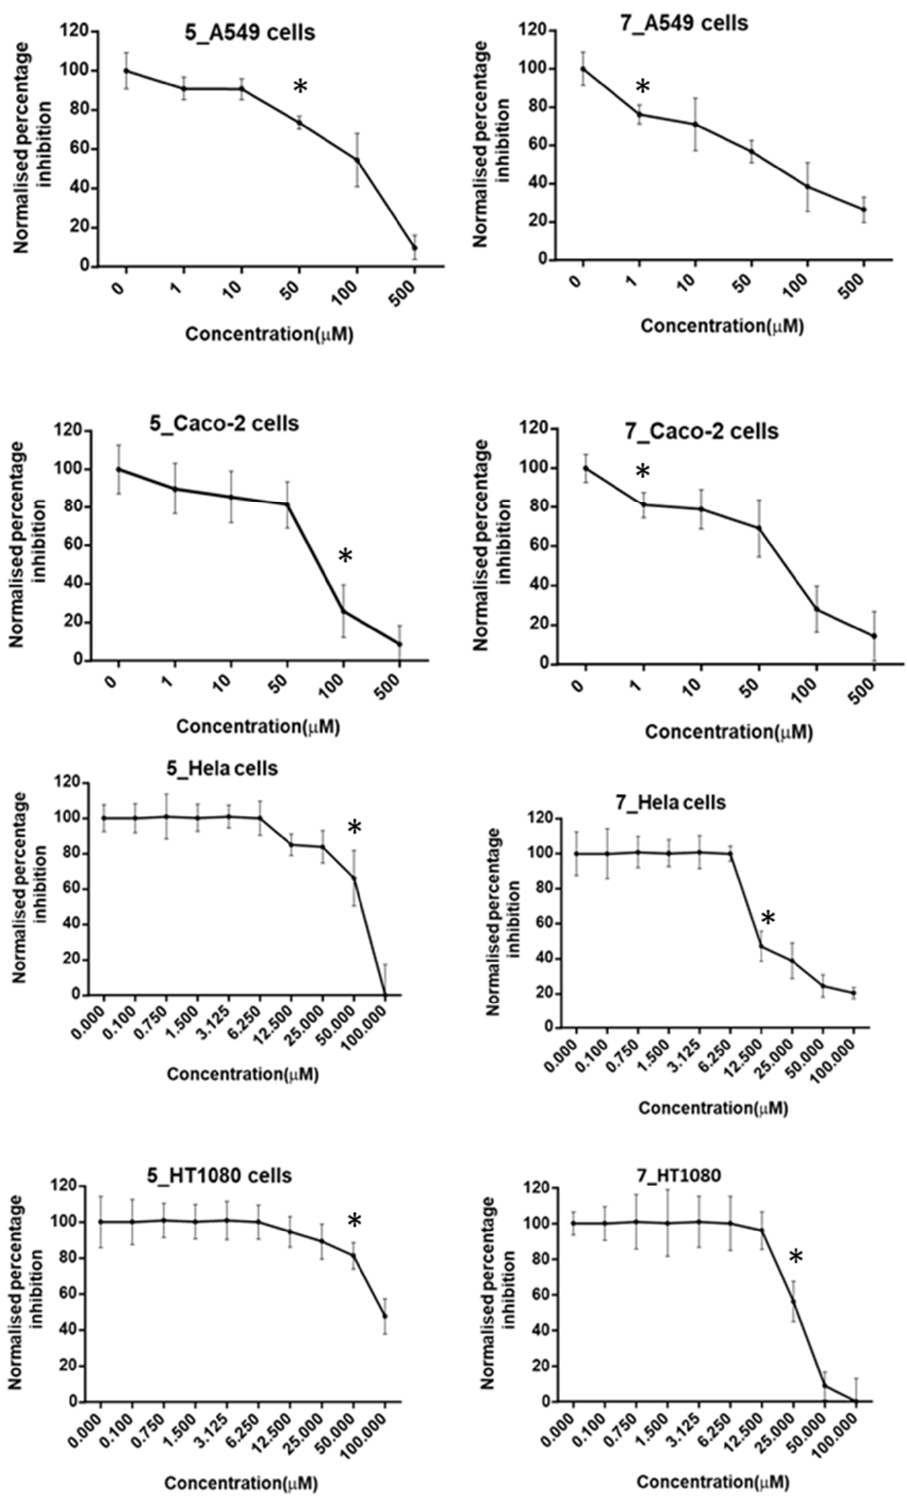
Figure 9. Normalised percentage cell viability inhibition of compounds 5 and 7 , measured by three independent MTT assays in A549 and Caco-2 cell lines and by three independent experiments with crystal violet staining in Hela and HT1080 cell lines. Cells were treated with different concentrations (from 1 and up to 500 µ M) of the compounds for 48 h, * = first concentration significant reduction in cell viability in comparison to the